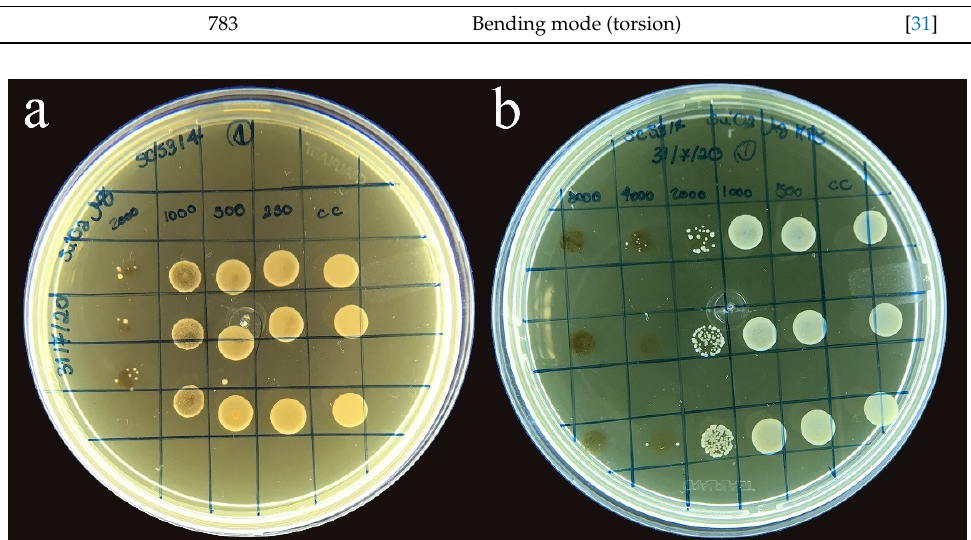
Figure 5. ( a ) Minimum inhibitory concentration of SiO 2 -Ag nanoparticles; ( b ) Minimum inhibitory concentration of SiO 2 -Ag-MPS nanoparticle.